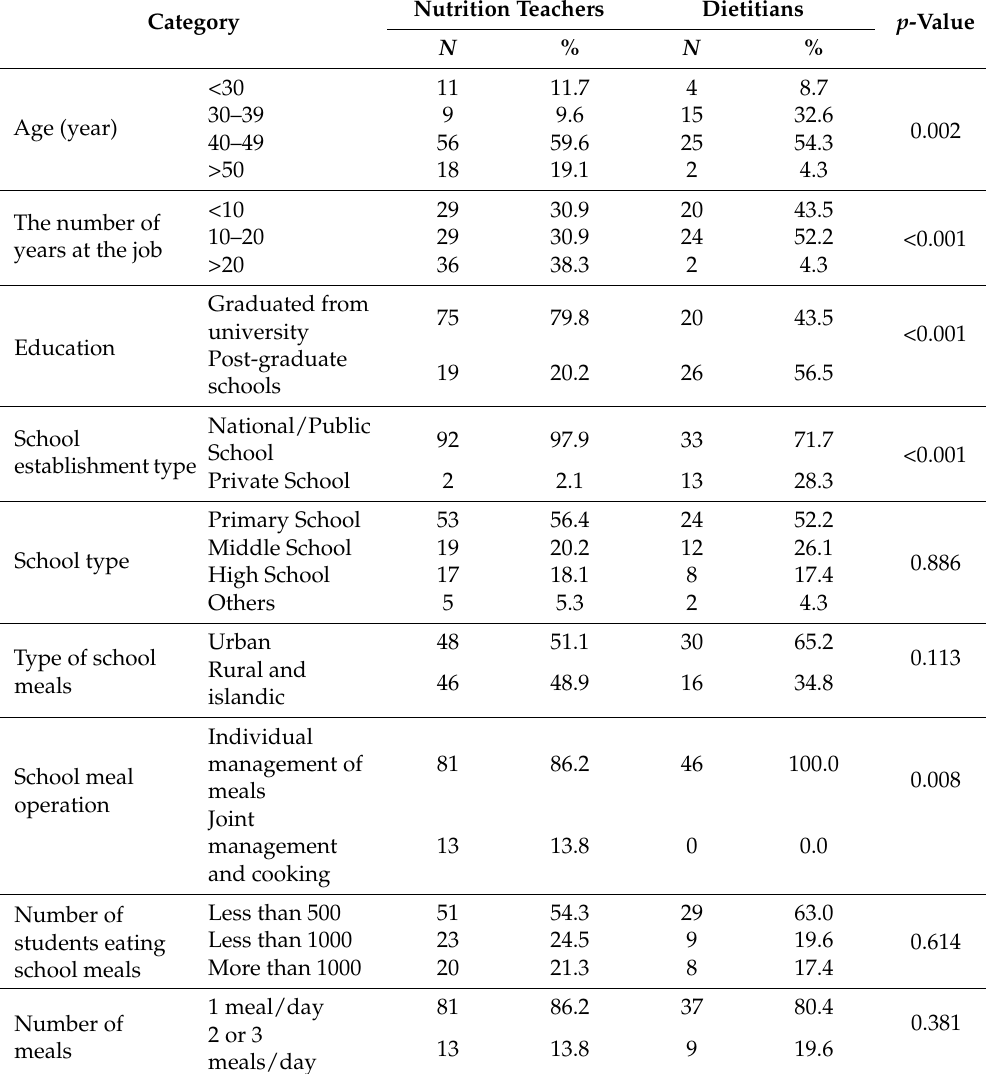
Table 2. Differences between nutrition teachers and dietitians by demographic characteristics and workplace